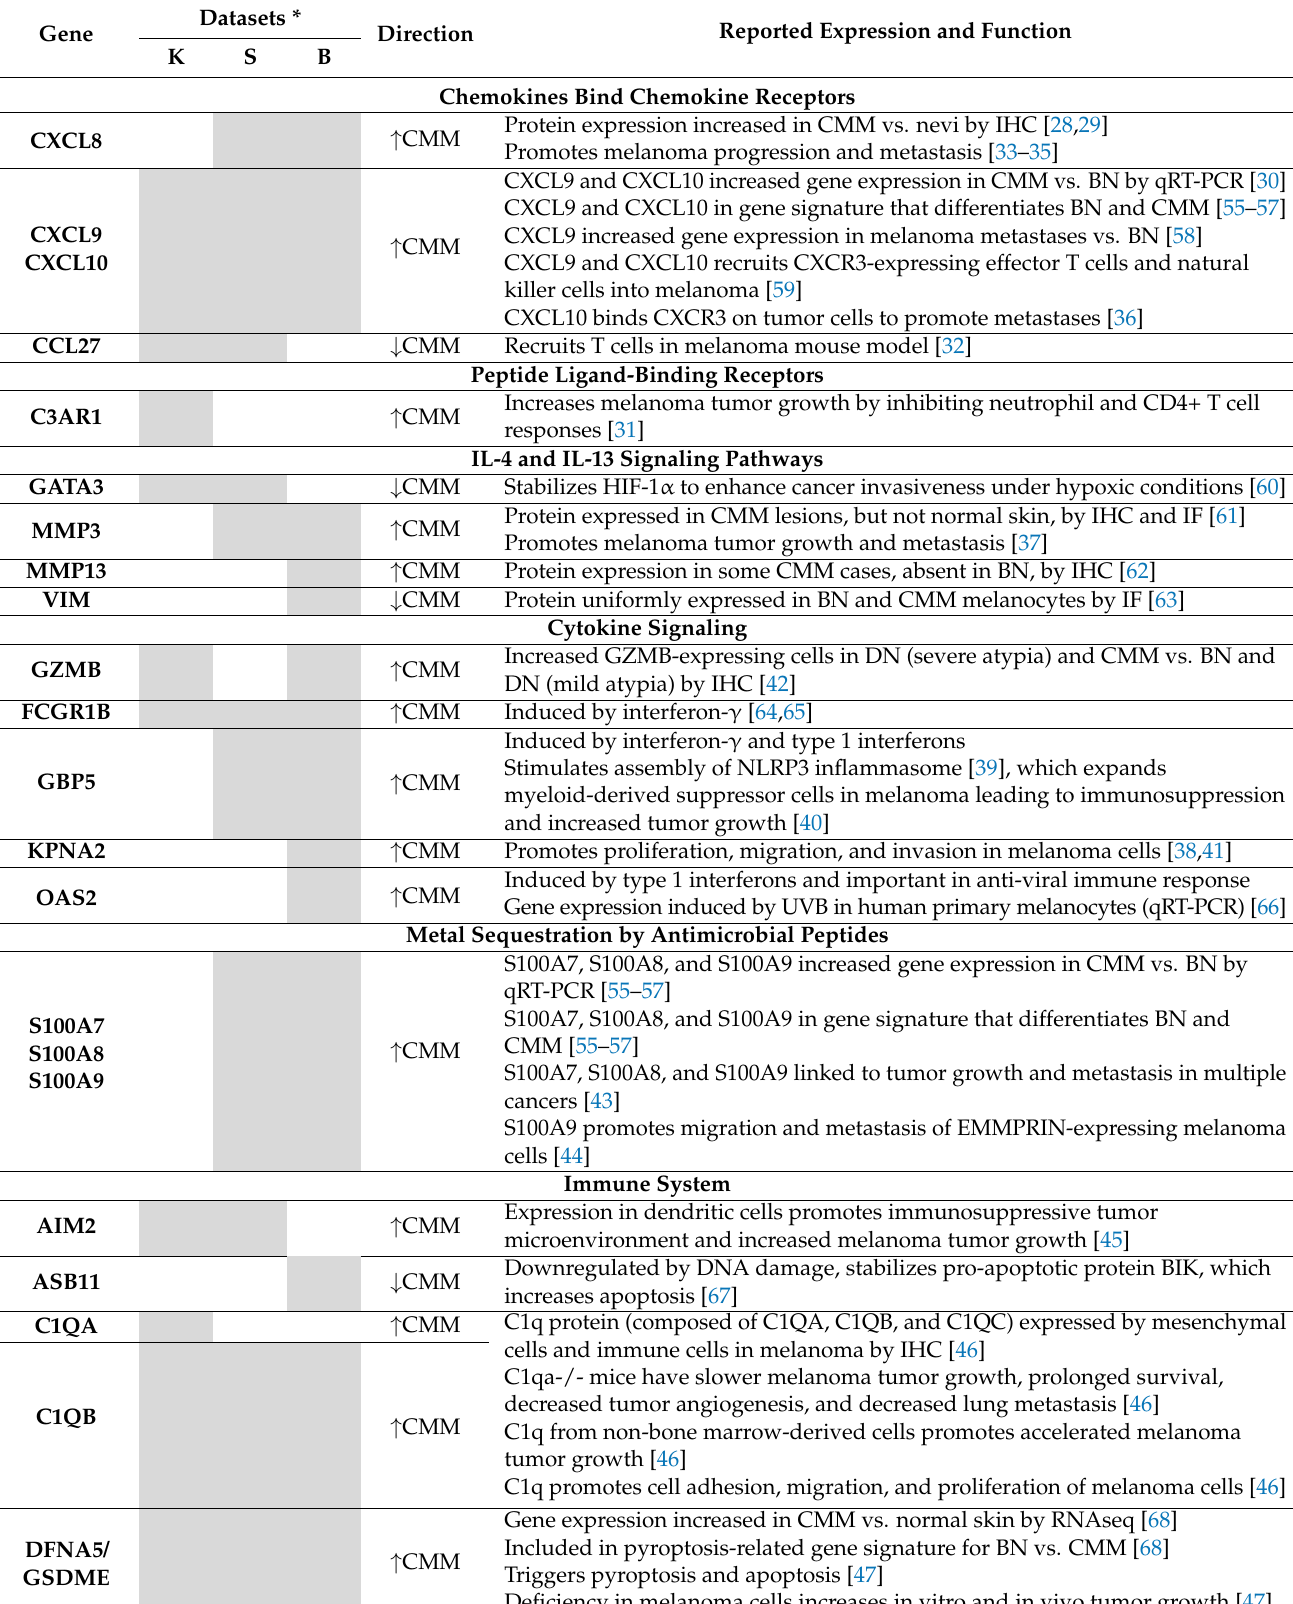
Table 2. Summary of the reported expression and function of the genes identified in the pathway